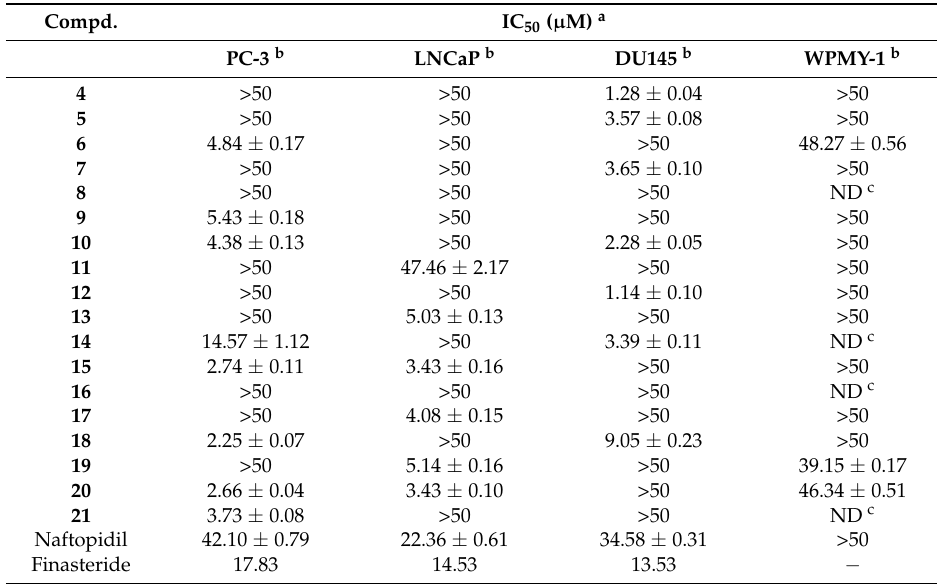
Table 1. In vitro cytotoxicity of compounds 4 – 21 .